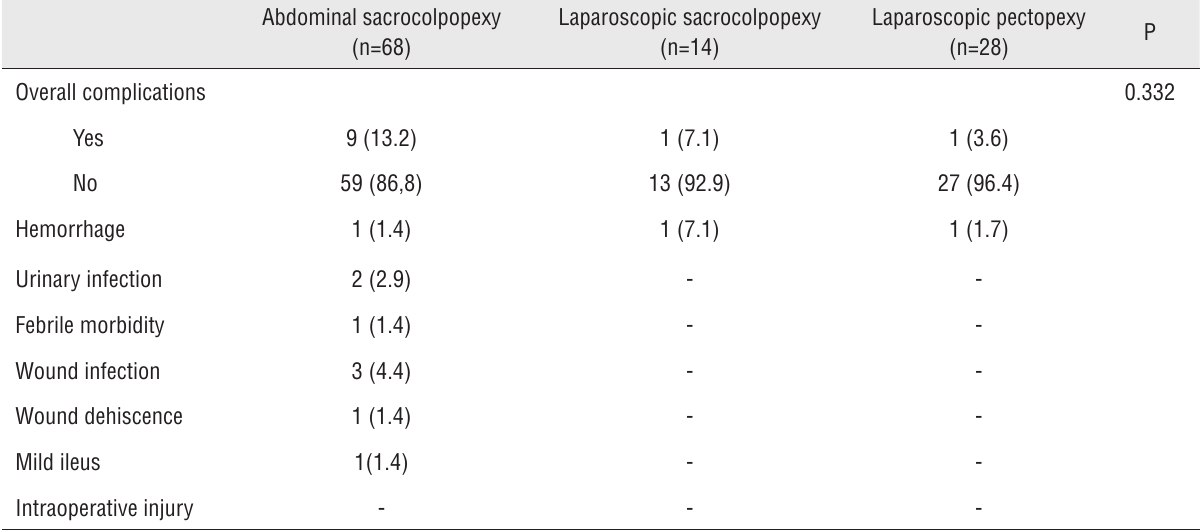
Table 3 - perioperative complications in the study